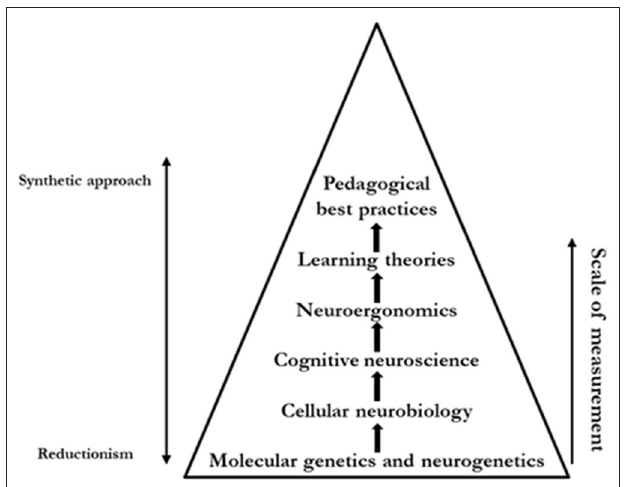
FIGURE 1 | The representation of a “ multi-layer cascade ” approach concurring in the development of applicable best practice regarding the learning